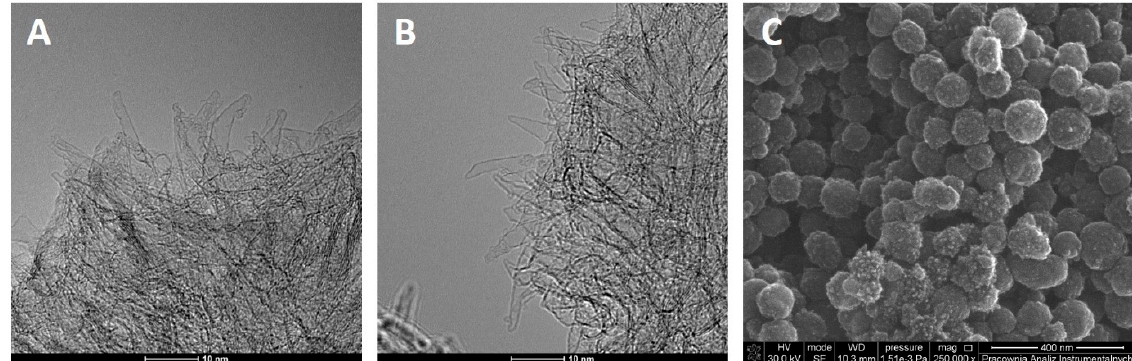
Figure 1. HRTEM ( A , B ) and SEM ( C ) images of studied SWCNH.